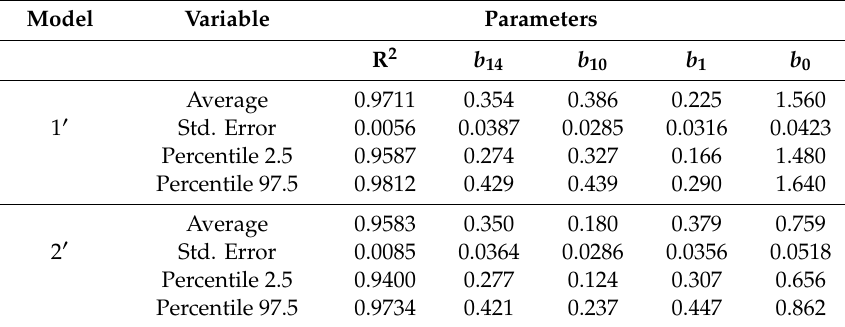
Table 4. Bootstrapping method